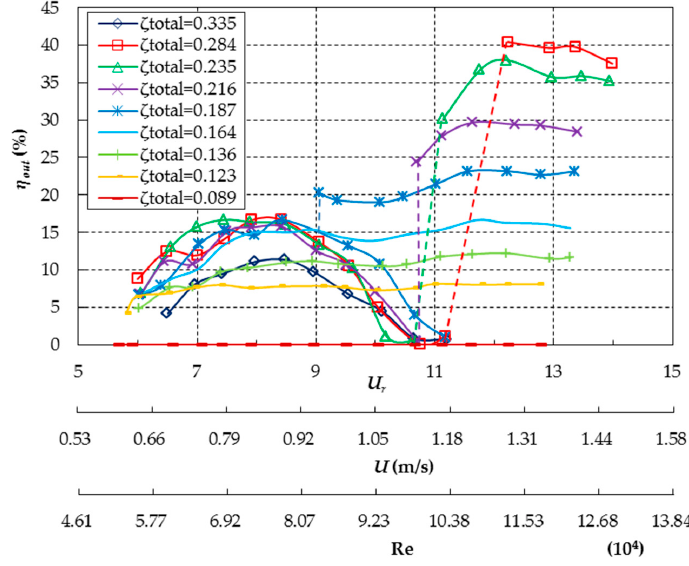
Figure 13. Efficiencies of the energy conversion for different ζ system (Dashed lines denote hard excitation).